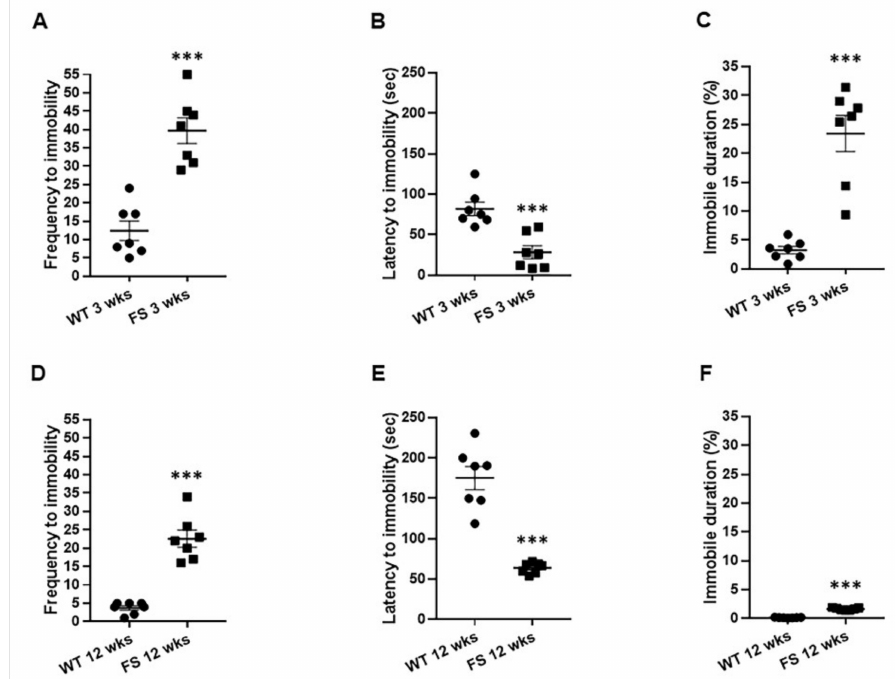
Figure 2. Increased depression-like behaviors in FS rats. Levels of depression-like behaviors of FS rats were significantly enhanced in comparison with those of wild-type littermates. Increased frequency of immobility in FS rats in the forced swim test ( A , D ). Decreased immobility latency in FS rats in the forced swim test ( B , E ). Increased percentage of immobility duration of FS rats in the forced swim test ( C , F ). Data are presented as means ± standard errors of the mean. *** p < 0.001, two-tailed t -test (WT 3 weeks, n = 7; FS 3 weeks, n = 7; WT 12 weeks, n = 7; FS 12 weeks, n =